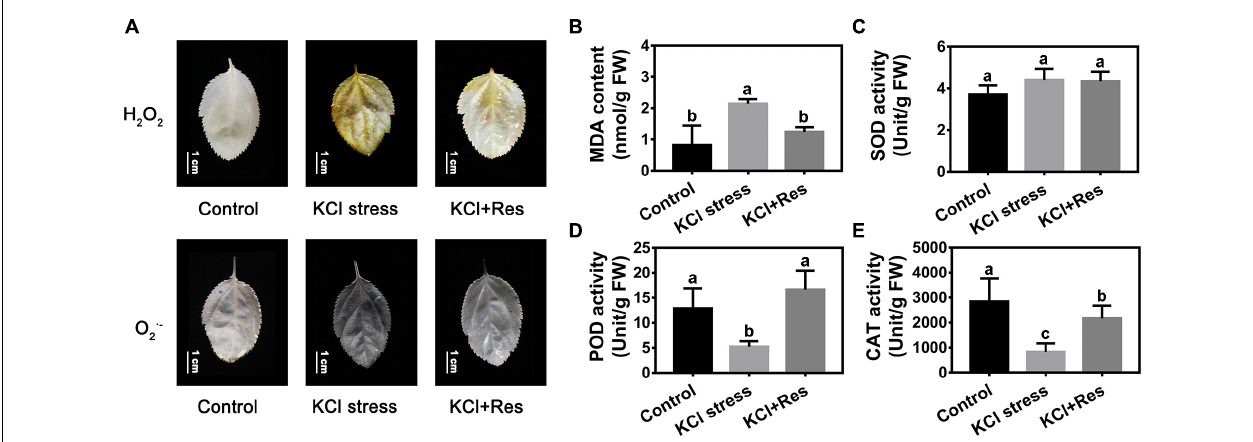
FIGURE 3 | Effects of Res treatment on H 2 O 2 , O 2 − (A) , and malondialdehyde (MDA) content (B) , superoxide dismutase activity (C) , peroxidase activity (D) , and catalase activity (E) under KCl stress. The bar (A) represents 1.0 cm. The data represent the mean ± SD of biological replicates. Different lowercase letters indicate significant differences according to Fisher’s least significant difference ( P < 0.05).